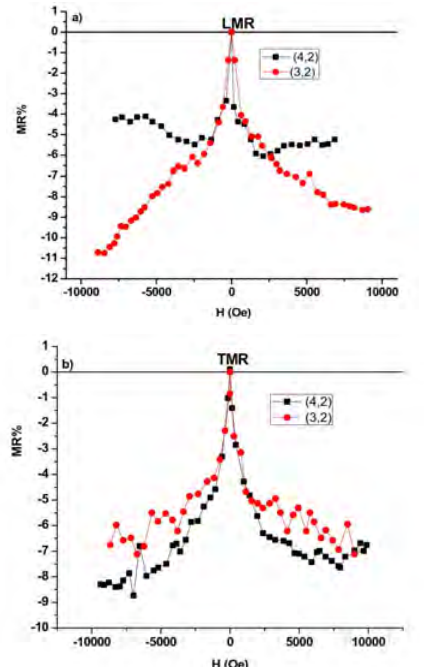
Fig. 5. LMR and TMR curves of Ni-Co/Cu multilayers in different Ni-Co layer thicknesses.